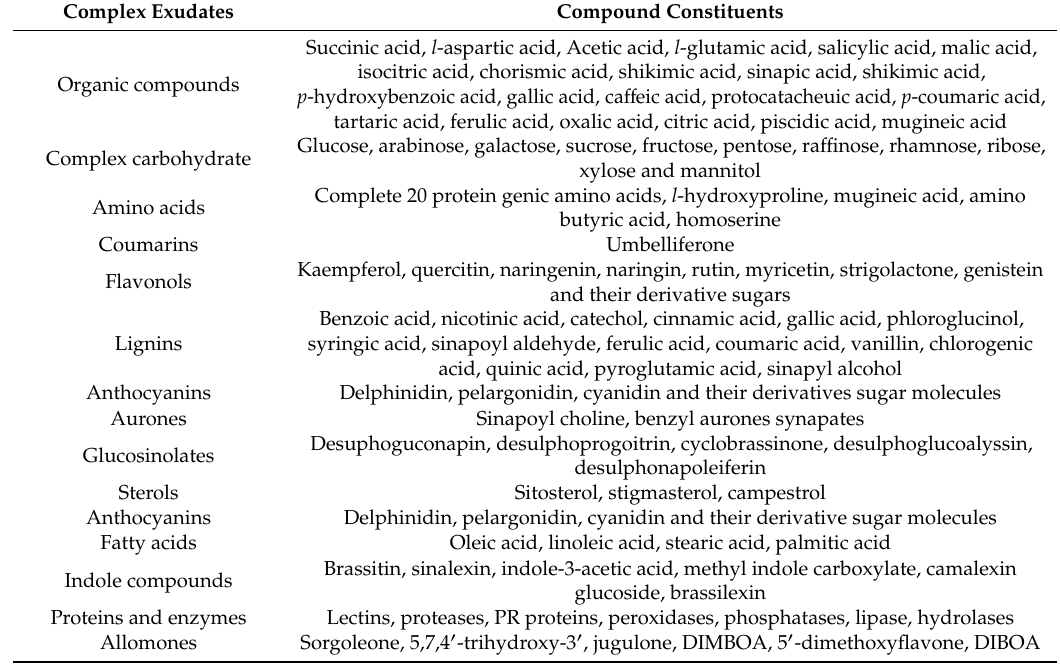
Table 1. Various complex exudates released via the plant root and their single